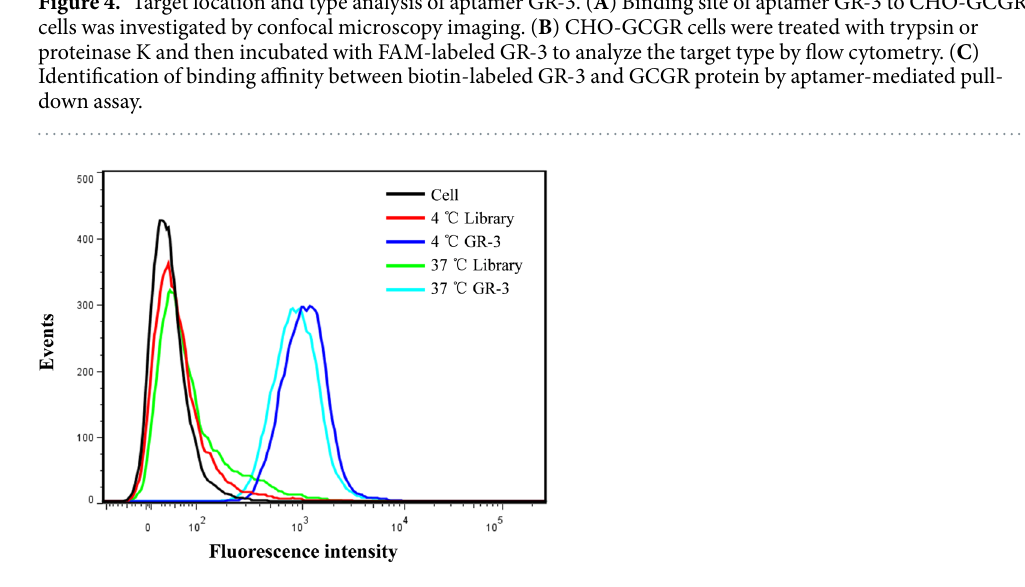
Figure 5. Effect of incubation temperature on binding ability of aptamer GR-3. CHO-GCGR cells were incubated with FAM-labeled GR-3, or library, at 4 °C or 37 °C and then analyzed by flow